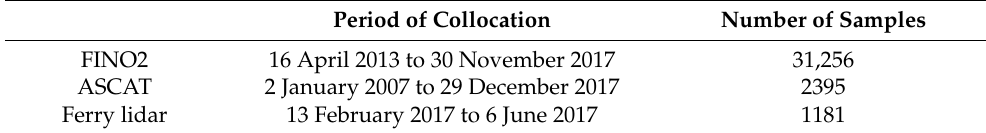
Table 2. NEWA WRF 30 min collocation period and number of samples with each of the